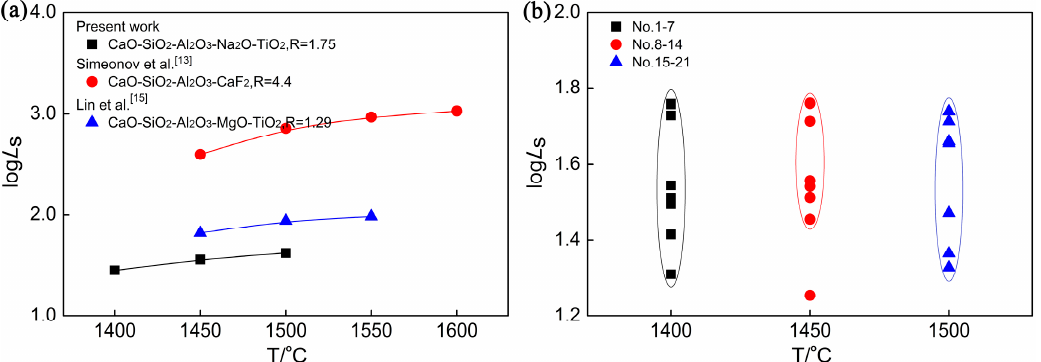
Figure 4. Effect of temperature on log L S .